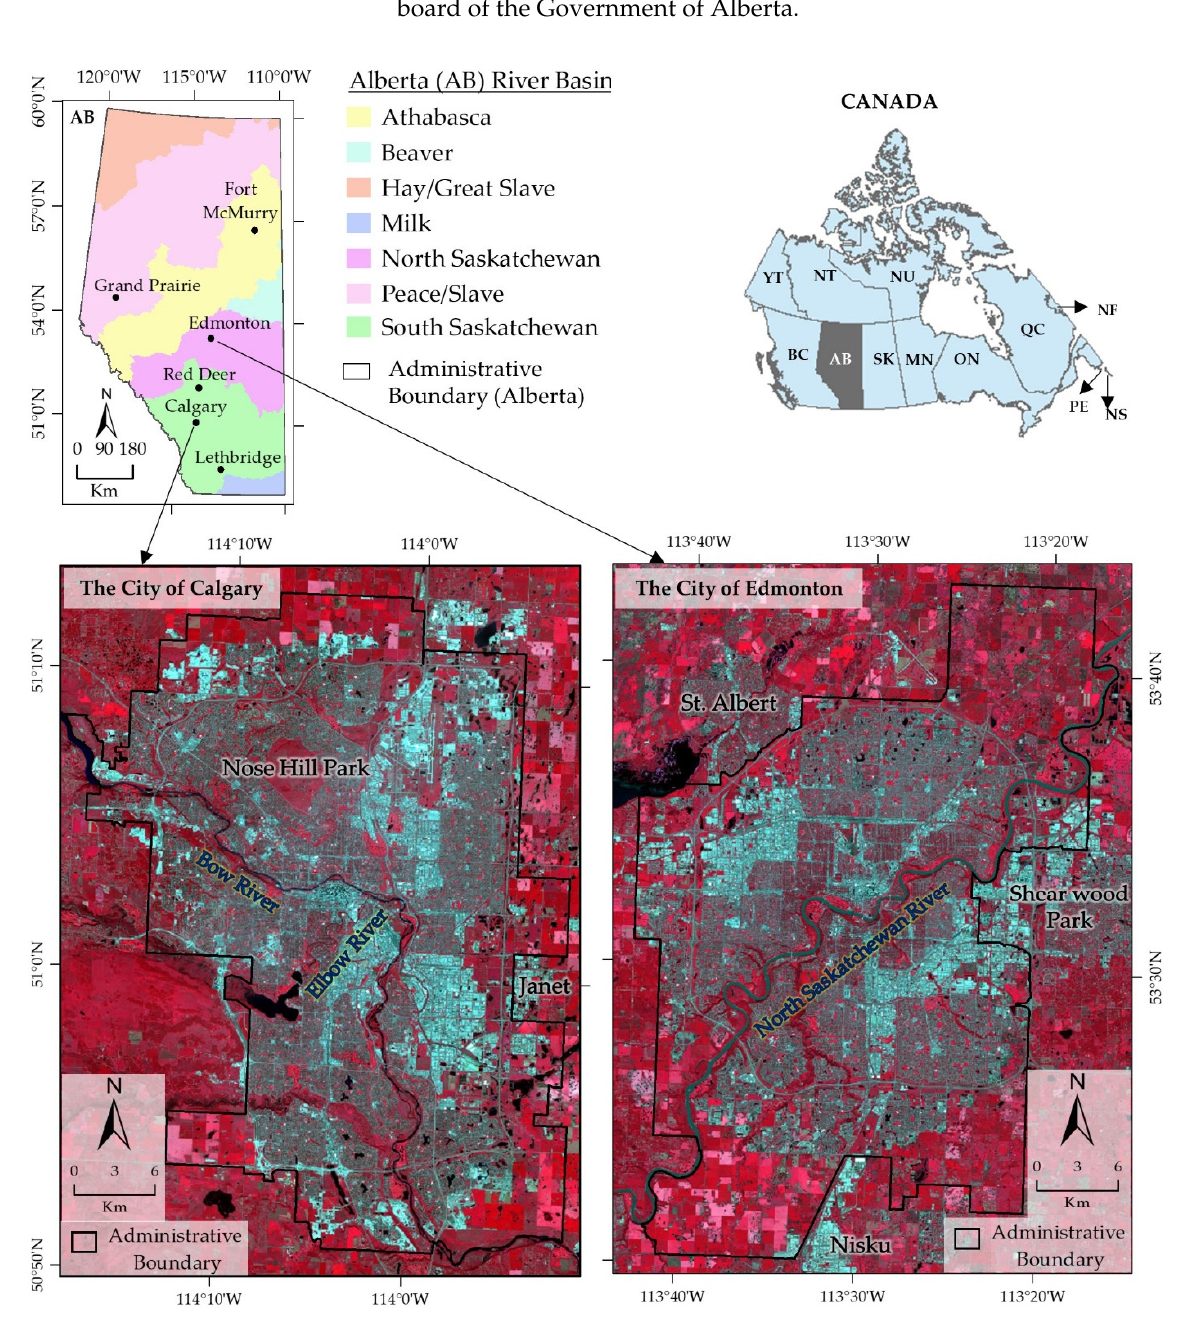
Figure 1. Study area showing the location of the city of Calgary and the city of Edmonton in the Canadian Province of Alberta. The Administrative boundaries of the cities for year 2020 were overlaid on Landsat-8 OLI false color composite images (RGB:5(Near Infrared)4(Red)3(Green)) acquired